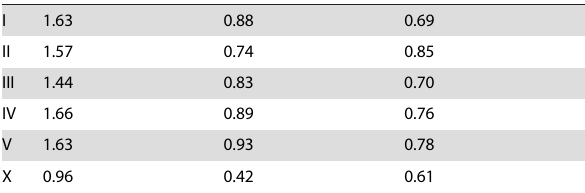
Table 2. Recombination breakpoints in